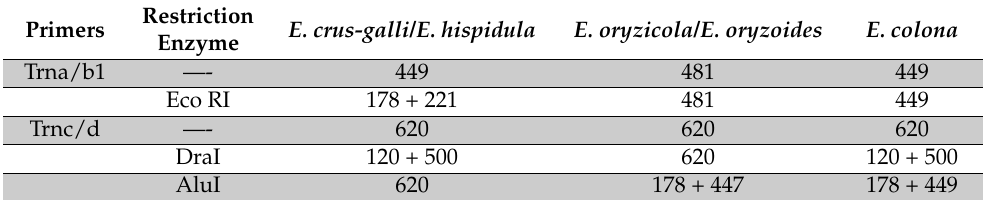
Table 1. Fragment size obtained by using the PCR_RFLP markers.